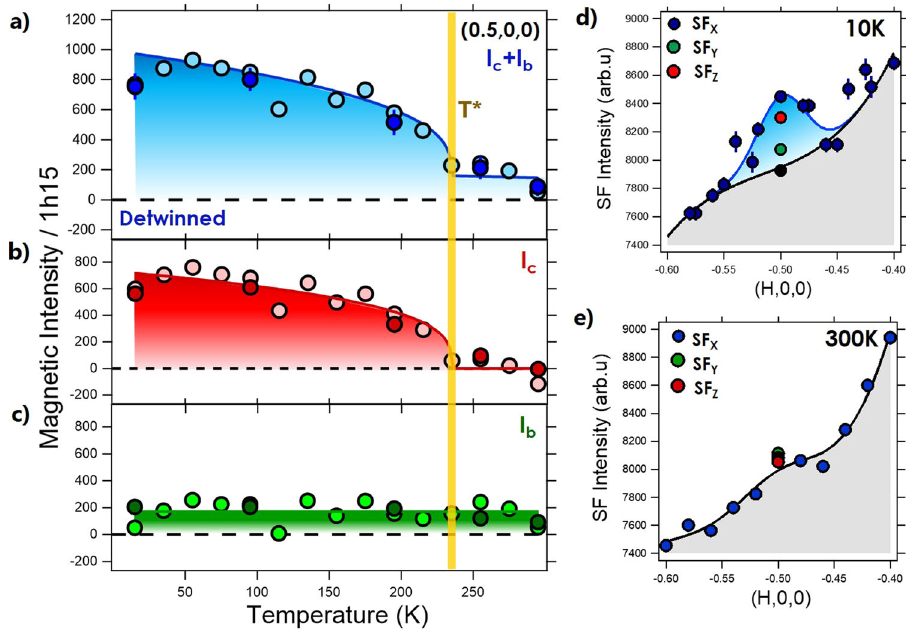
Fig. 3 Temperature dependence of the biaxial magnetism in detwinned YBa 2 Cu 3 O 6.6 (YBCO-d). a Temperature dependence of the magnetic intensity measured at (0.5,0,0) as extracted from XYZ polarization analysis (XYZ-PA) (dark blue circles) and background subtracted SF X data (light blue circles). Temperature dependence of b the out-of-plane magnetic response, I c , (dark red circles) and c the in-plane magnetic scattering, I b , (dark green circles) as extracted from XYZ-PA. Light red circles in b correspond to I c as extracted from the SF X data in a subtracted from the fi t to the in-plane component in c . Light green circles in c correspond to I b as extracted from the SF X data in a subtracted from the fi t to the out-of-plane component in b . The blue symbols in panel a correspond to the sum I c + I b . H-scans across (0.5,0,0) measured in the Spin Flip ( SF X , Y , Z ) channels at d 10K and e 300 K. The magnetic intensity appears as a Gaussian signal centered at 10K and drops at 300K in YBCO-d. Data in a – e were measured on Thales with the sample aligned in the (1,0,0)/ (0,0,1) scattering plane. Error bars (sometimes smaller than the points size) represent one standard deviation. Raw data of a , b are given in Supplementary Fig. 5.